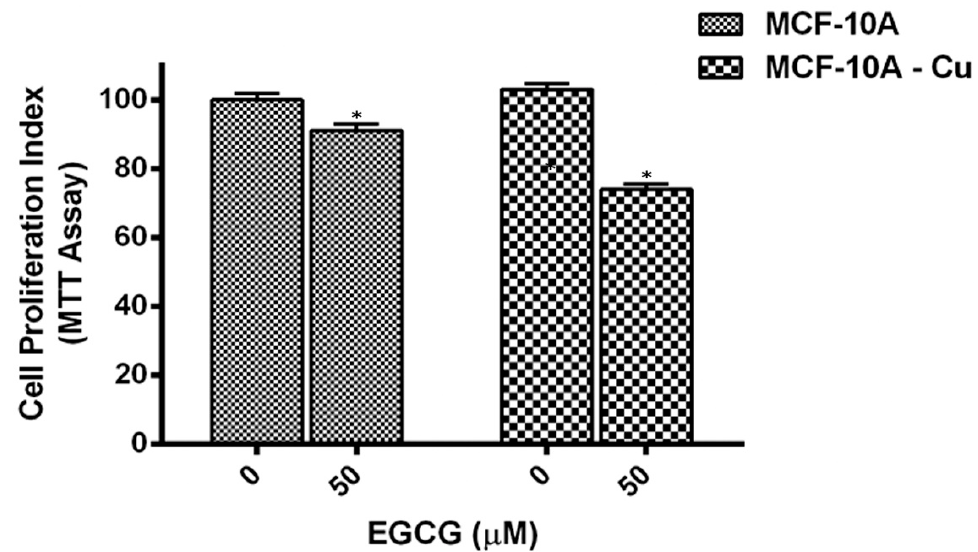
Figure 7. Effect of EGCG on inhibition of cell proliferation in MCF-10A (normal breast epithelial cells) and MCF-10A cells cultured in media supplemented with Cu (II) (MCF-10A-Cu). Both MCF-10A and MCF-10A-Cu (normal cells cultured in a medium containing 25 µM CuCl 2 ) were subjected to treatment with EGCG for 72 h at concentrations, as indicated in the figure. Cell proliferation was subsequently estimated by MTT assay as described in the Materials and Methods section. Values reported are ± S.E. of three independent experiments. * p value < 0.01 when compared to control.